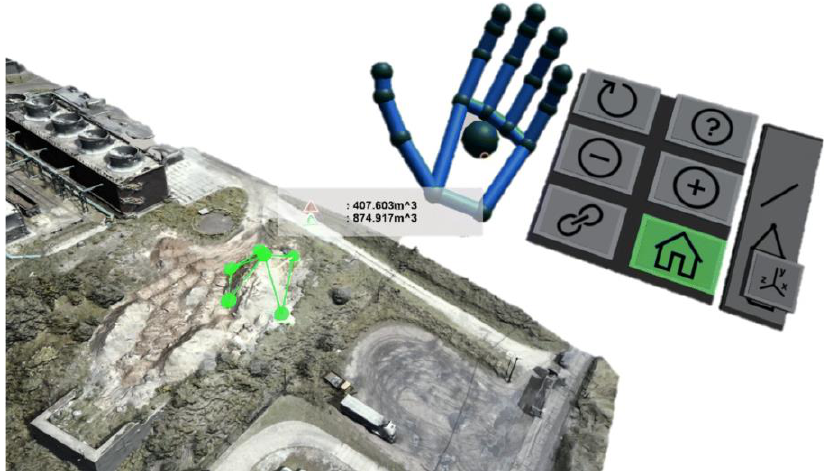
Figure 12. The volume measurement of a pile of sand in the photogrammetry model with hand gestural input [101].